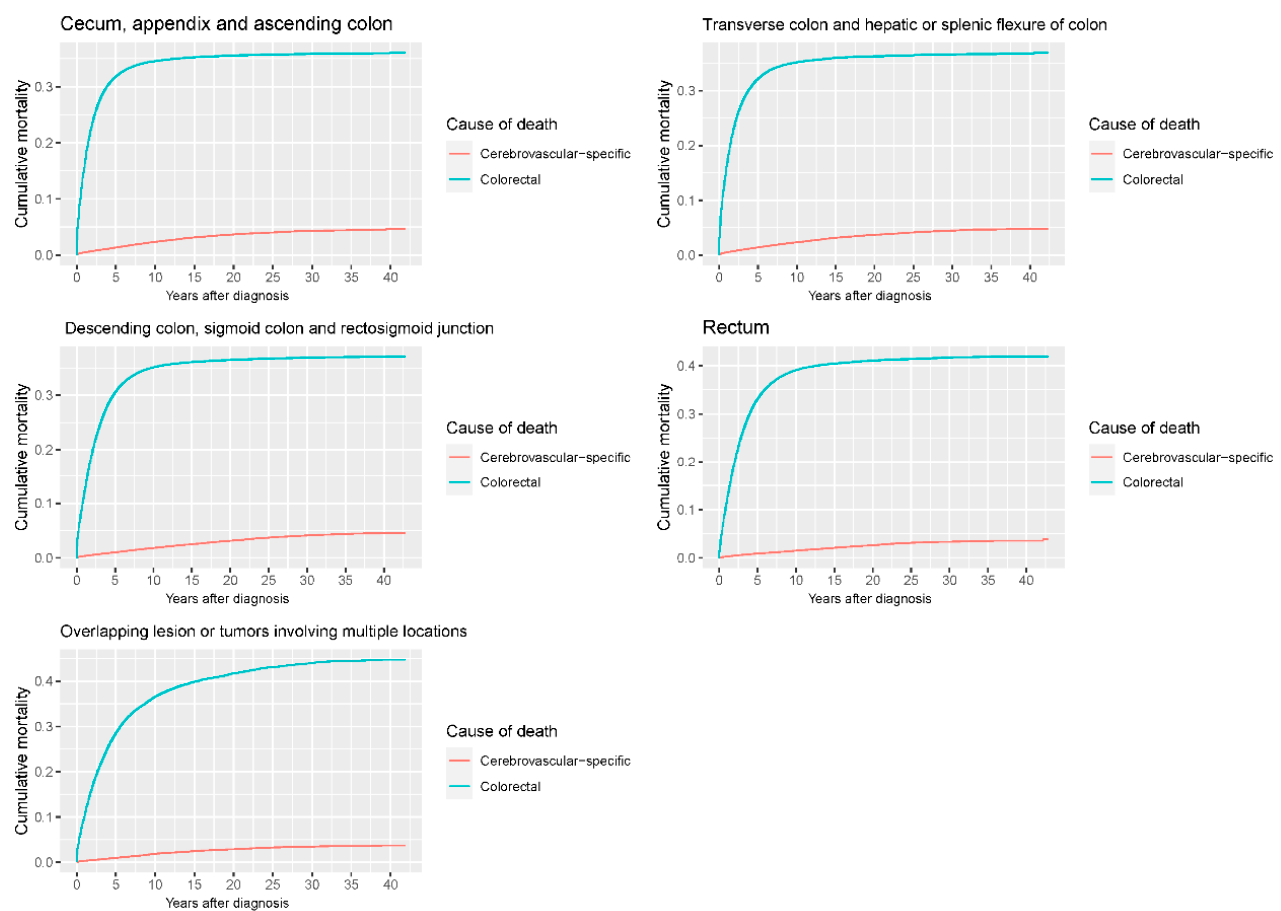
Figure 10. Cumulative cerebrovascular-specific and colorectal cancer-specific mortality stratified by tumor site. Univariate analyses using a competing risk model were performed to test the relationship between tumor location and CVSM in CRC patients ( p < 0.0001), and differences in cumulative mortality among different subgroups were analyzed by Gary’s test.